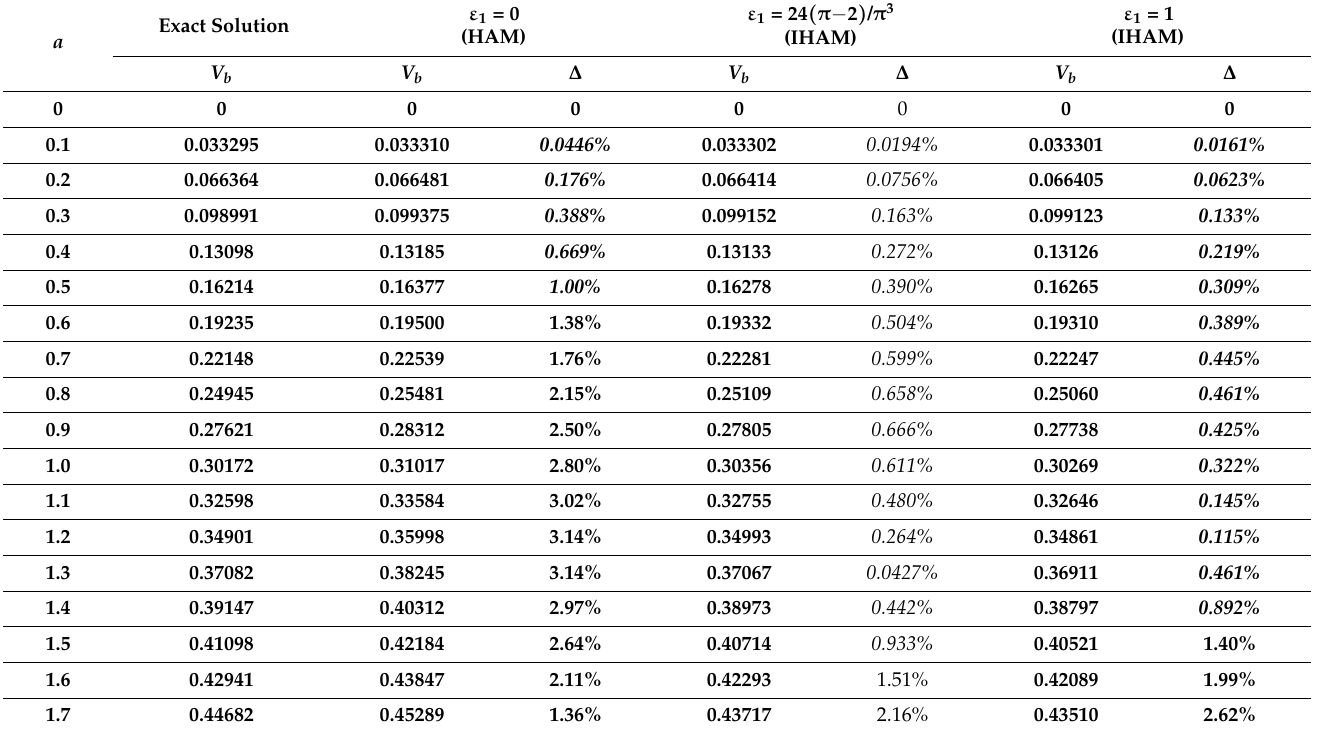
Table 2. 2st-order numerical solutions V with exact solutions V b